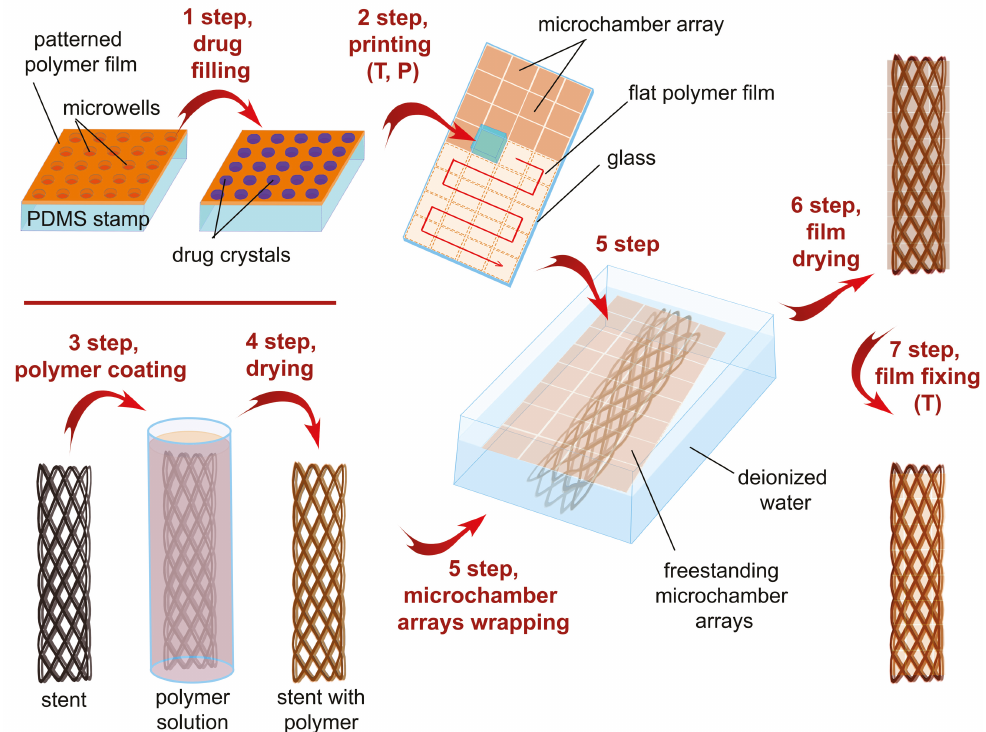
Figure 1. General scheme of tracheal stent surface functionalization by biodegradable microchamber arrays containing anti-inflammatory drug.